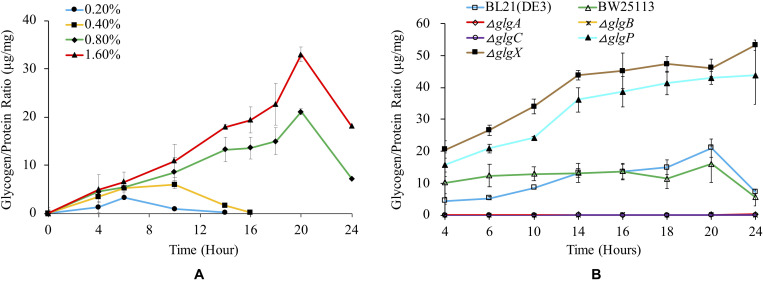
Quantification of glycogen accumulation in E. coli strains with different media. (A) Glycogen accumulation of E. coli BL21(DE3) in 1 × M9 minimal medium supplemented with different percentages of glucose (0.2, 0.4, 0.8, and 1.6%). (B) Glycogen accumulation of a variety of E. coli strains in 1 × M9 minimal medium supplemented with 0.8% glucose. In order to remove the influence of the biomass change during bacterial growth, glycogen amount (μg) was adjusted by total protein amount (mg). Three independent replicates were performed, and error bars were present.